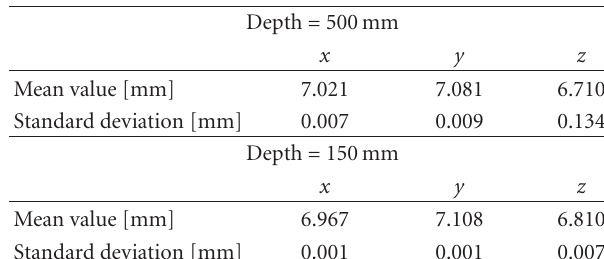
Table 1: Summary of displacement experimental data: mean values and standard deviations of measured